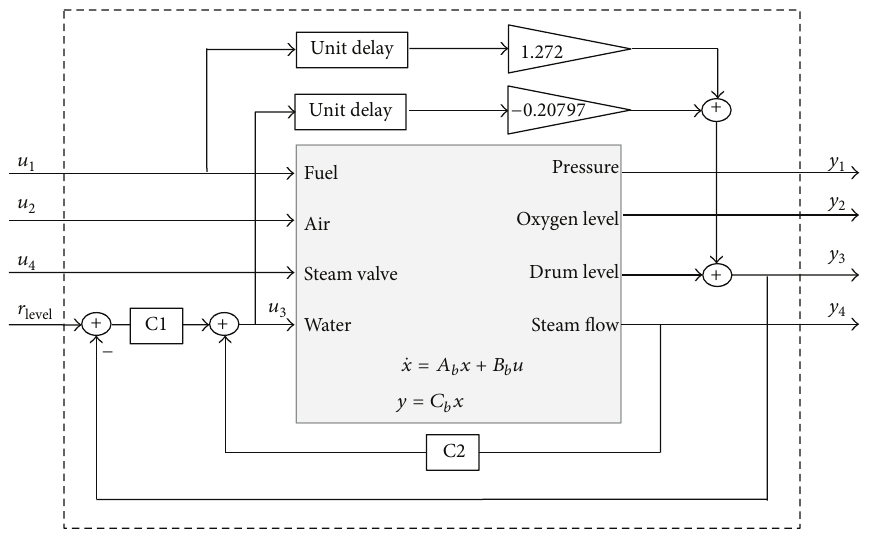
Figure 6: Stabilization scheme for the boiler without direct feedthrough.